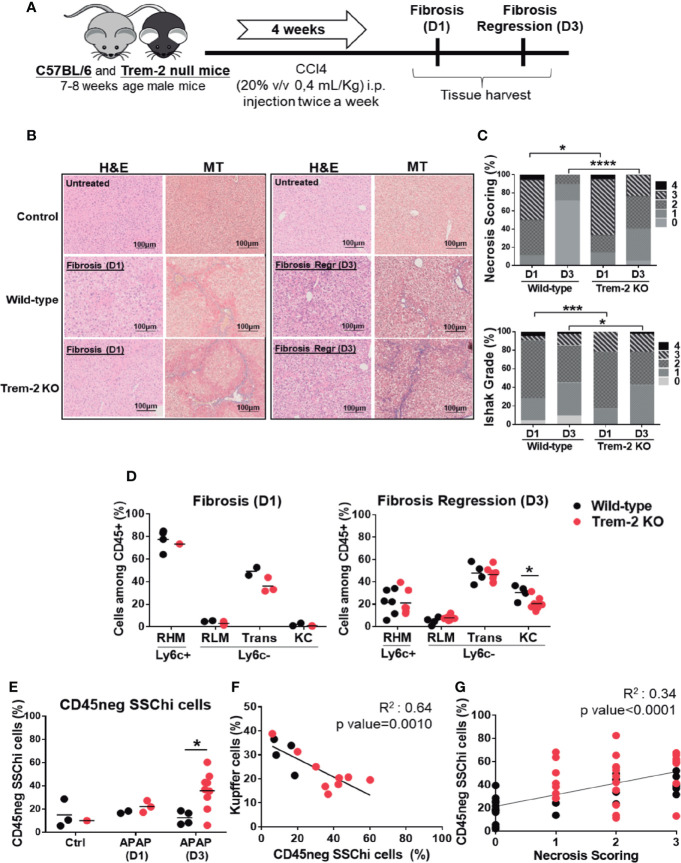
Responses to chronic liver injury are impaired in Trem-2 KO mice. Chronic liver injury was induced by administration of CCl4 during 4 weeks, twice a week. Mice were analyzed one or three days after the last injection, corresponding to fibrosis-D1 and fibrosis regression-D3 time points in wild-type mice (A). Liver necrosis was evaluated using hematoxylin-eosin (H&E) staining (B) and scored from 0 to 4 according to location and extension of the necrotic lesions (C). Masson’s trichrome (MT) staining was used to identify and quantify collagen fibers (blue) (B) using an adapted Ishak grading (D). Applying the flow cytometry criteria depicted in
Figure 2
 we quantified cell frequencies of distinct macrophage populations: recruited hepatic macrophages (RHM); Kupffer cells (KC); transition macrophages (Trans); recruited-like macrophages (RLM) (E) and of non-hematopoietic CD45neg SSChi population (F) in wild-type and Trem-2 KO mice for control, fibrosis-D1 and fibrosis regression-D3 time points. Inverse correlation of KC frequency with CD45neg SSChi population at Fibrosis Regression-D3 (G). Correlation of CD45neg SSChi cells frequency with necrosis scoring at fibrosis regression-D3 time point (H). Symbols represent values from individual mice. Group mean values are presented. Statistics: For necrosis and Ishak grade scorings, groups were compared using Chi-square test (n=18-48 mice/group) (C). Two-way ANOVA in (E) and (F) Pearson’s correlation test in (G, H) *, p<0.05 ***, p<0.001, ****, p<0.0001.